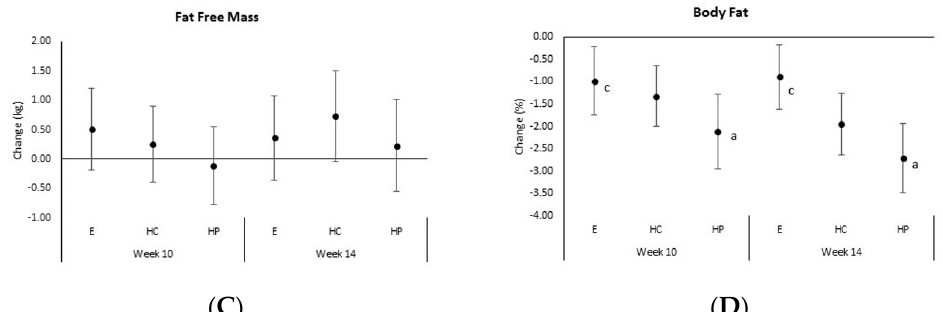
Figure 3. ( A ) Body weight, ( B ) fat mass, ( C ) fat ‐ free mass, ( D ) body fat. Mean changes with 95% confidence intervals (CIs) from baseline in body composition variables for the exercise only (E), higher carbohydrate (HC), and higher protein (HP) groups. Means and 95% CIs completely below baseline represent a significant change over time. a = p < 0.05 difference from E; b = p < 0.05 difference from HC; c = p < 0.05 difference from HP.